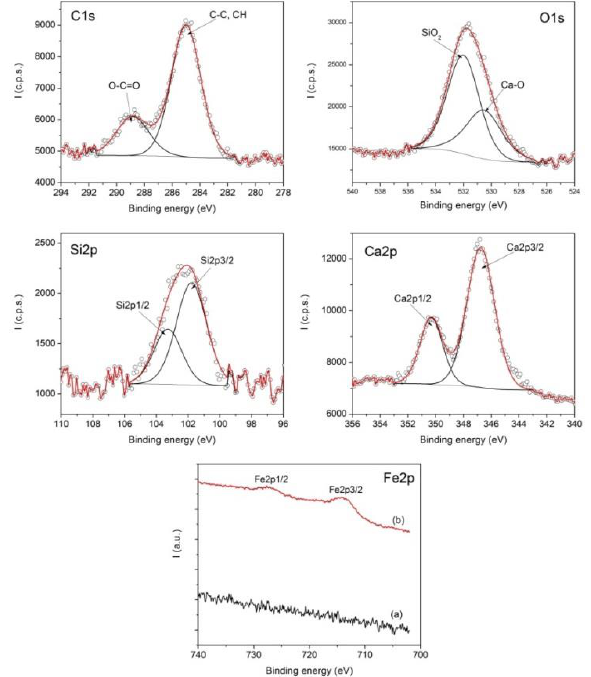
Figure 4. High-resolution XPS spectra of C1s, O1s, Si2p, Ca2p and Fe2p (spectrum (a) before sputtering; spectrum (b) after sputtering at 1500 V 60 min and 2000 V 180 min) from the sample Fe 3 O 4 -Ca(OH) 2 .